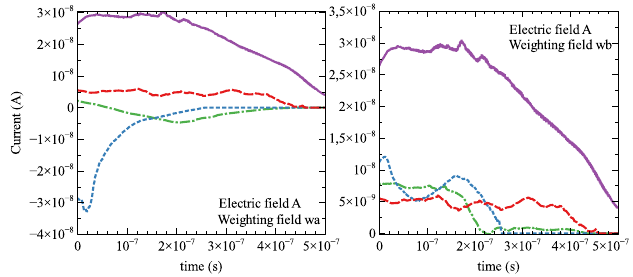
Fig. 19. Pulses simulated for the mpfd with the electrostatic potential A and the weighting fields wa (left) and wb